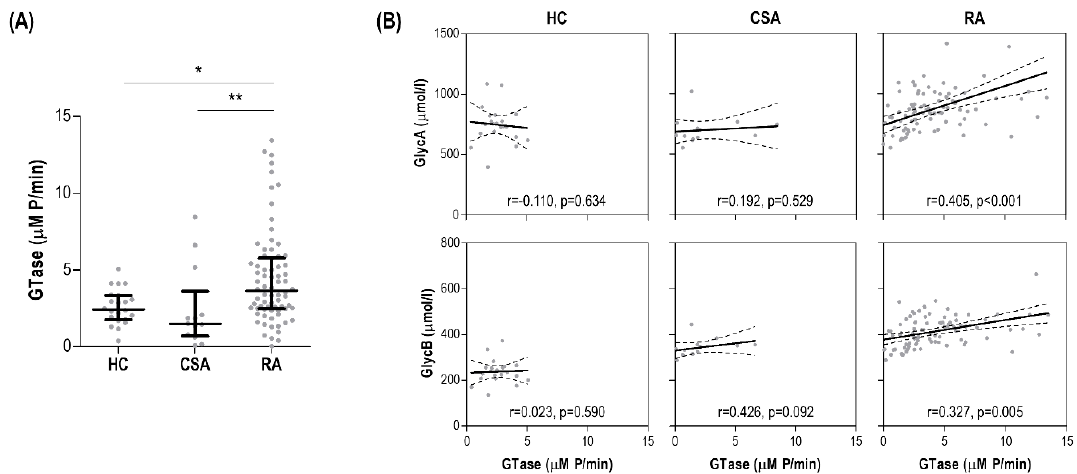
Figure 4. Glycoprotein signals and serum glycosyltransferase activity. ( A ) Glycosyltransfersase (GTase) activity was measured in serum samples and compared across groups. Differences were assessed by Kruskal–Wallis tests with Dunn–Bonferroni posthoc tests. The p -values from the latter were indicated as follows: * p < 0.050 and ** p < 0.010. ( B ) The associations between serum GTase (horizontal axis) and glycoprotein levels (vertical axis) in all the study groups were studied by correlation analyses (Spearman ranks’ tests) and indicated at the bottom of each graph. Next, integrative analyses to visualize all these associations were performed. Correlation analyses confirmed strong correlations between GlycA and both GTase and cIMT in RA, but not in CSA. Moreover, GlycB was more strongly correlated with inflammatory markers and disease indices